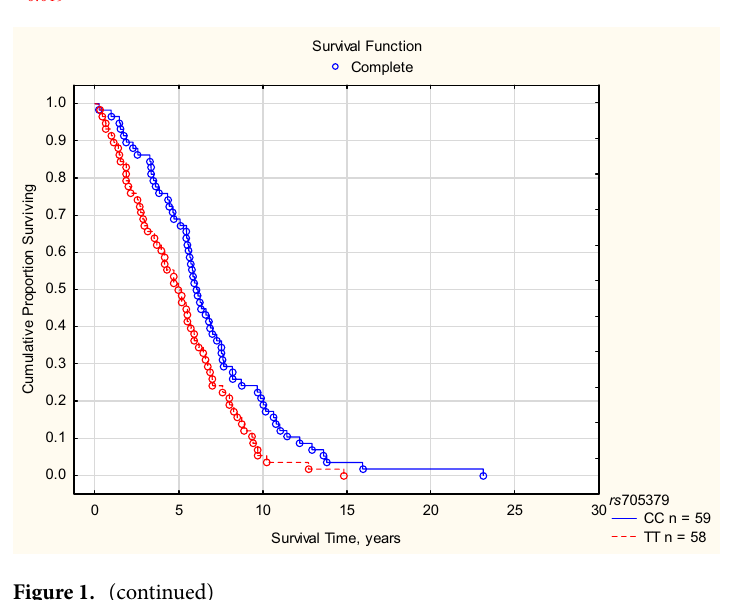
(Table 1). Cardiovascular mortality was a cause of death in 485 patients (354 subjects died from cardiac reasons, 131—from vascular diseases). If cardiovascular survival probability was compared between genotypes of PON1 rs705379 (TT vs. CT vs. CC), the log-rank test revealed a significant difference (P = 0.025). Homozygotes TT of PON1 rs705379 revealed lower cardiovascular survival than the C allele bearers (Fig. 1a). A significance was shown for cardiac deaths in the recessive mode of inheritance (Fig. 1b) and mortality from CHD and its complications between the TT and CC genotypes (Fig. 1c) but not for vascular deaths, also if deaths from ICS were analysed separately (n = 98). These significances yielded P < 0.05 in the Cox proportional hazards models including age, gender, diabetic nephropathy, and rs705379 TT vs. CC + CT (HR 1.269, 95% CI 1.030–1.565, P = 0.025 for cardiovascular mortal- ity; HR 1.343, 95% CI 1.053–1.713, P = 0.018 for cardiac mortality). Significantly associated with cardiovascular and cardiac mortalities were also age (HR 1.013, 95% CI 1.006–1.021, P = 0.006 for cardiovascular; HR 1.014, 95% CI 1.004–1.023, P = 0.004 for cardiac mortality) and diabetic nephropathy (HR 1.366, 95% CI 1.134–1.645, P = 0.001 for cardiovascular; HR 1.278, 95% CI 1.028–1.589, P = 0.027 for cardiac). In the Cox proportional haz- ards model, the difference between the PON1 rs705379 TT and CC genotypes concerning mortality from CHD and its complications was connected only with the TT homozygosity (HR 1.549, 95% CI 1.064–2.255, P = 0.023). There were no associations between rs662 and rs854560 and cardiovascular, cardiac, and vascular mortality in HD